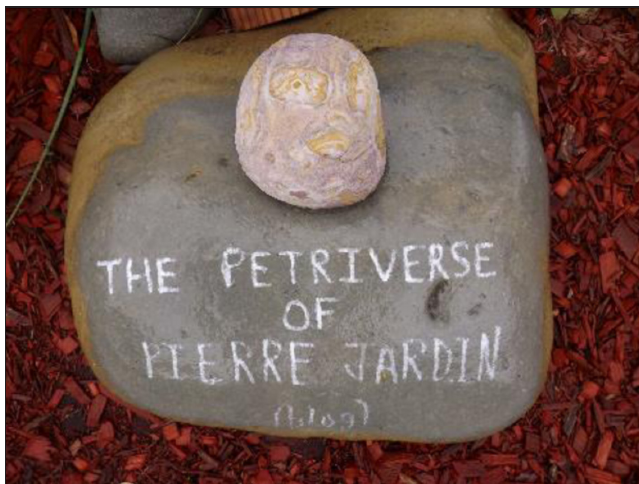
Figure 5: Petriverse Headstone with rock showing face-like pattern. Photo: Paul